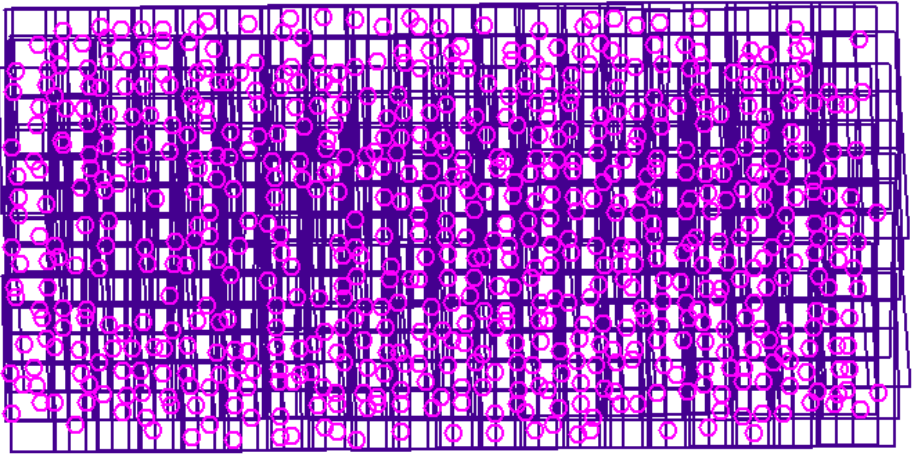
Figure 8. Block ITPs extracted